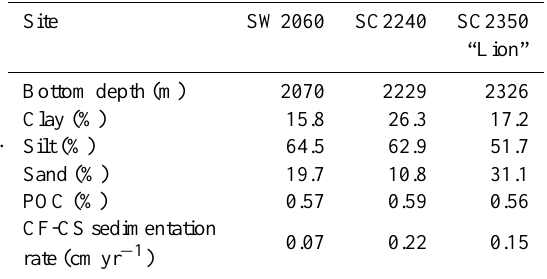
Table 3. Characteristics of surficial (0–0.5cm) sediment from cores collected in April 2009 at three different coring sites. Classification